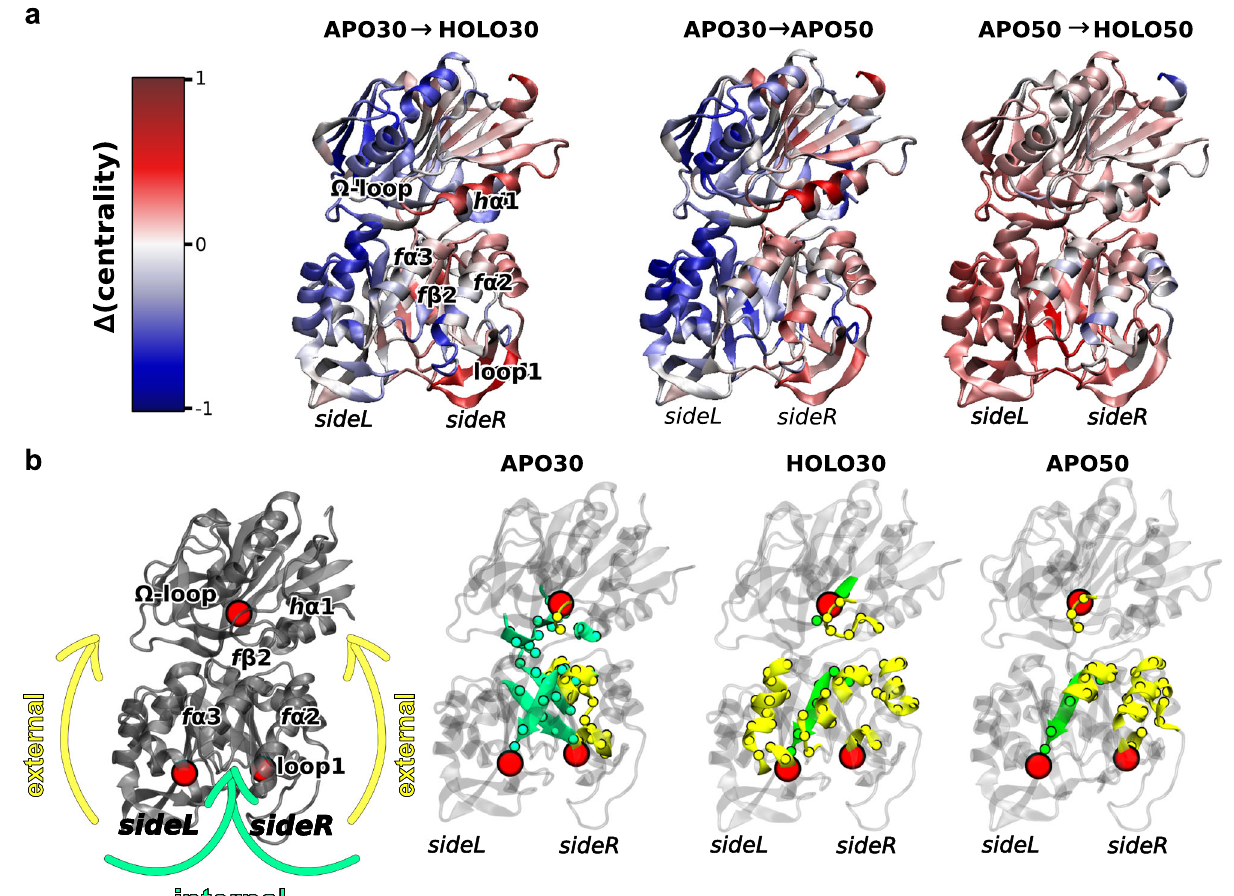
b Comparison of speci fi c mutual information pathways connecting the PRFAR phosphate binding sites (residues f T104 and f A224 in HisF, red spheres located in sideL and sideR ) to the active site ( h G50 in HisH, red sphere). Secondary structure elements involved in the shortest communication pathways are highlighted, separating contributions of surface (solvent-exposed) amino acids ( “ external ” , in yellow) from those buried in the protein ( “ internal ” , in green). The information pathways in the allosterically inactive apo enzyme at 30°C ( apo30 ) differ from those of the IGPS activated by a temperature increase ( apo50 ) or by effector binding( holo30 ),whichinsteadfeaturesomesimilarities.Sourcedataareprovided as a Source Data fi